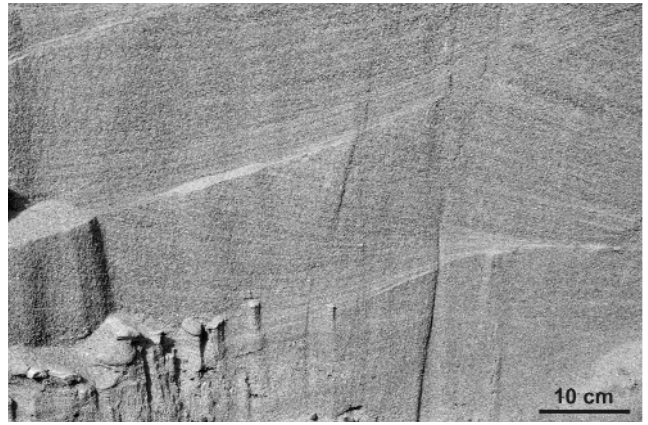
Figure 4. Example of festoon cross-stratification within the channel sedi- ments that records dispersed turbulence flows, with a dominant direction towards the northeast, sub-parallel to the channel trend. See Figure 3 for location in the trench wall.